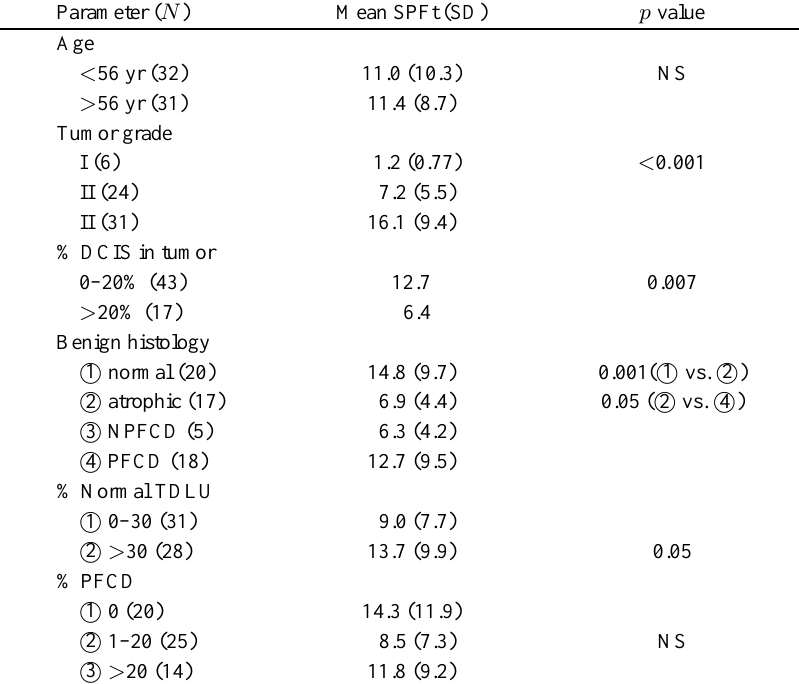
Correlation between neoplastic cell proliferation (SPFt) and clinicopathologic